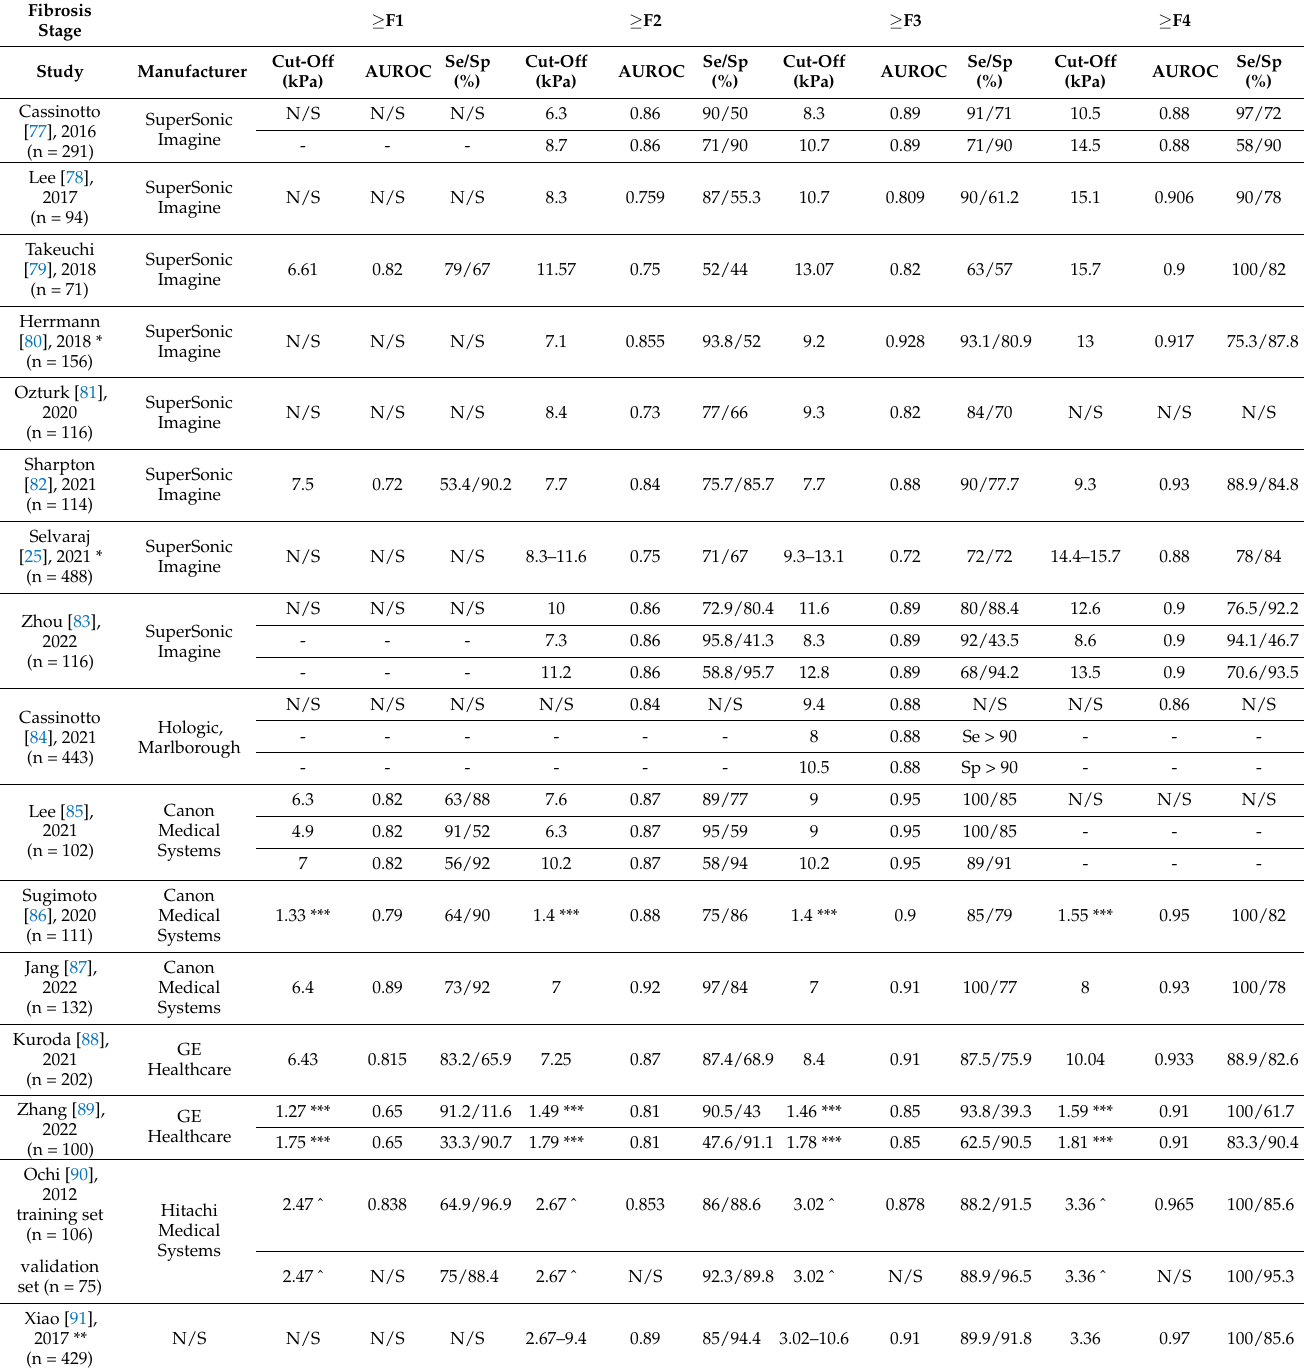
Table 1. Performance of LS cut-off values by 2D-SWE for detecting different stages of liver fibrosis in biopsy-proven